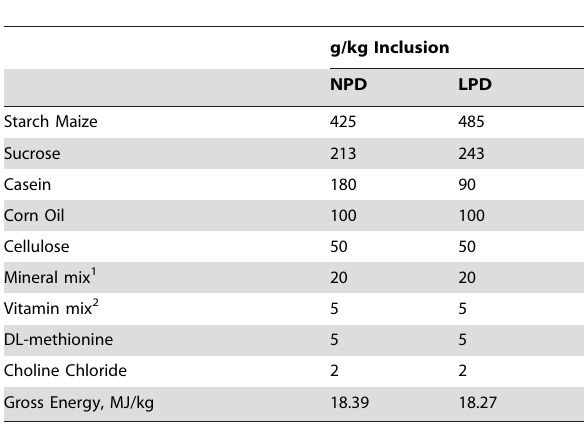
Table 1. Macro- and micronutrient composition of the diets used within the